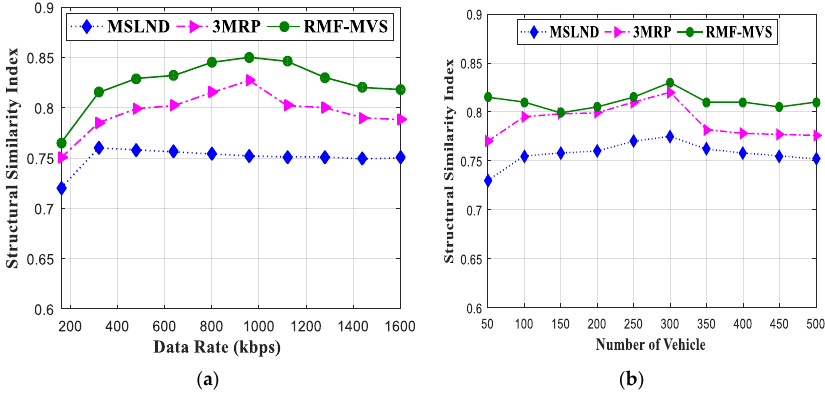
Figure 7. Structural SIMilarity (SSIM) index Results Based on Different Number of ( a ) Vehicles and ( b ) Data Rates.